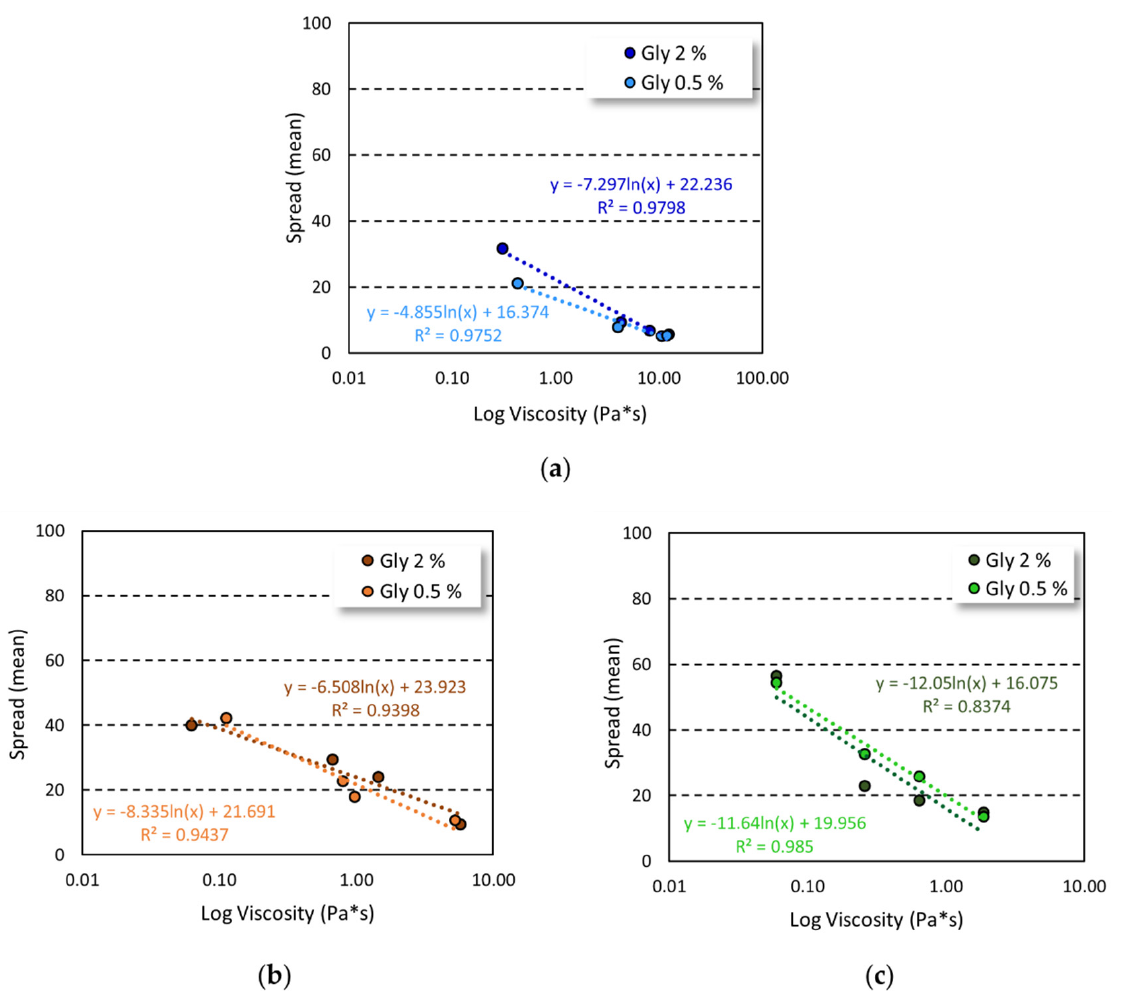
Figure 3. Relationship between viscosity and spreadability of the alcohol-based gels. Spreadability plotted against the viscosity of gel based on carbopol ( a ), HPMC ( b ), and HEC ( c ).